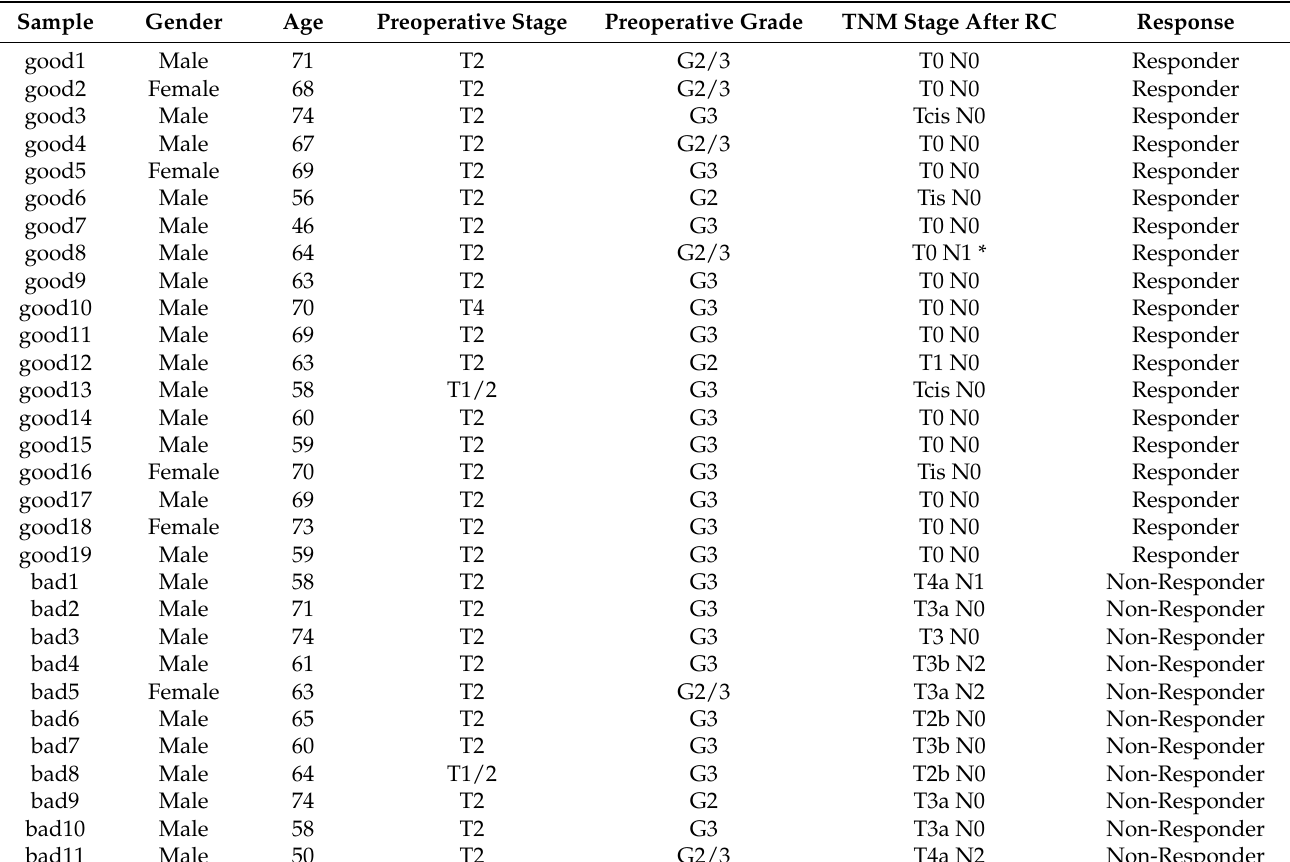
Table 1. Clinicopathological characteristics of MIBC patients examined by gene expression